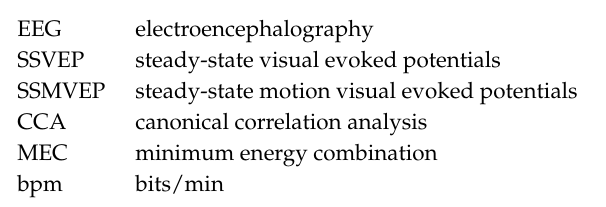
Figure S1: Overview of the SSMVEP1 and SSMVEP2 stimulus concepts., Figure S2: Overview of the SSMVEP3, SSMVEP4, and SSMVEP5 stimulus concepts., Figure S3: Participants’ subjective questionnaire responses., Figure S4: CCA maximum correlation coefficient spectrum., Table S1: Average results of participants’ subjective questionnaire responses, on a scele